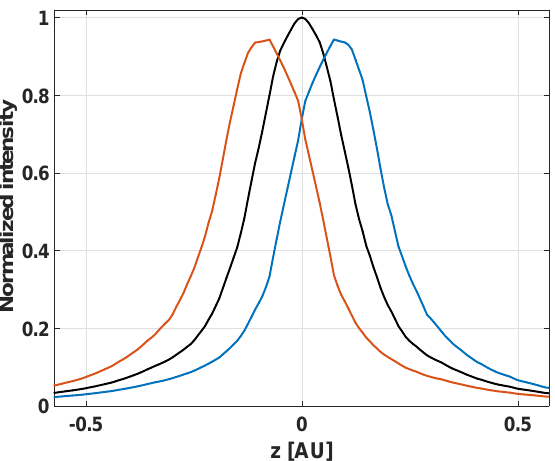
Figure 4. Simulation of depth scans in z-direction in focus (black), with pinhole displacement far (blue) and close (red) using a 10 AU pinhole and ideal lenses.